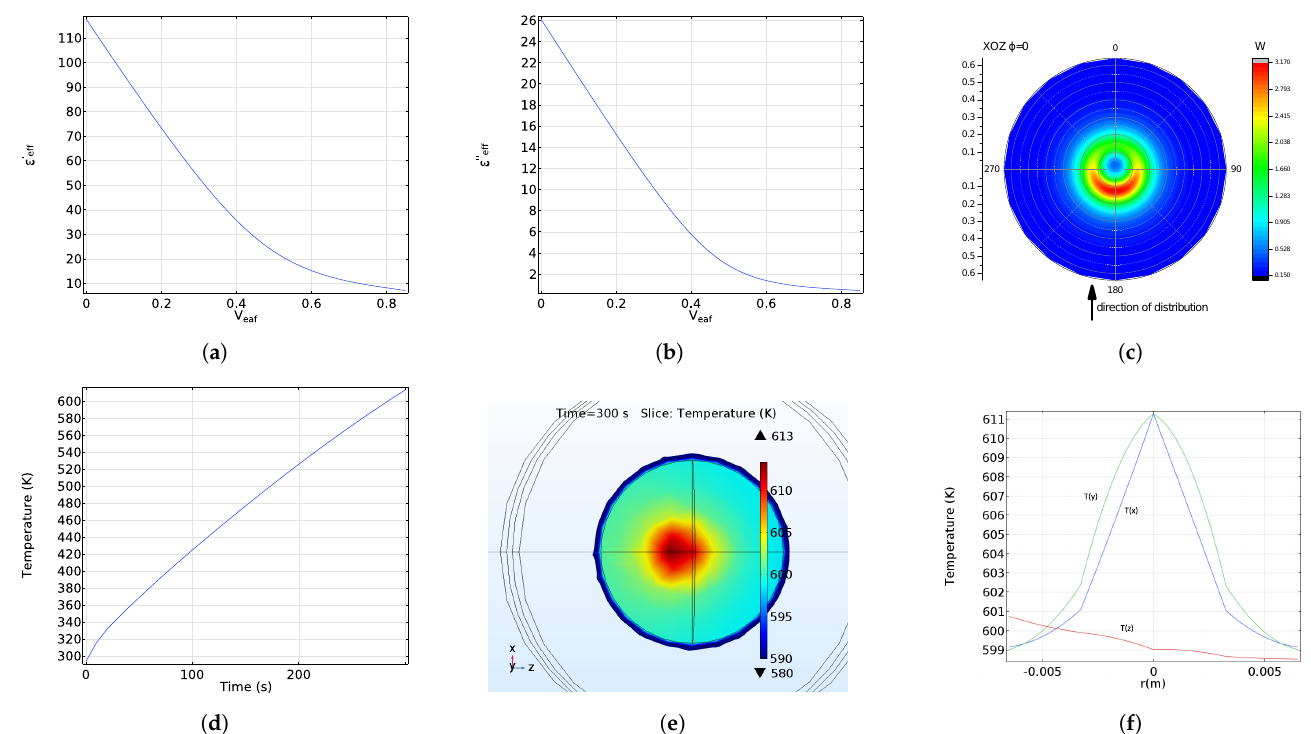
Figure 7. Dependencies of dielectric permittivity (real and imaginary parts) on the volume fraction of EAF dust for a biochar conductivity of σ eaf = 10 12 s − 1 ( a , b ). Distribution of heat sources (analytical solution for plane wave in free space) ( c ), temperature curve ( d ), and temperature distribution within pellet ( e , f ).